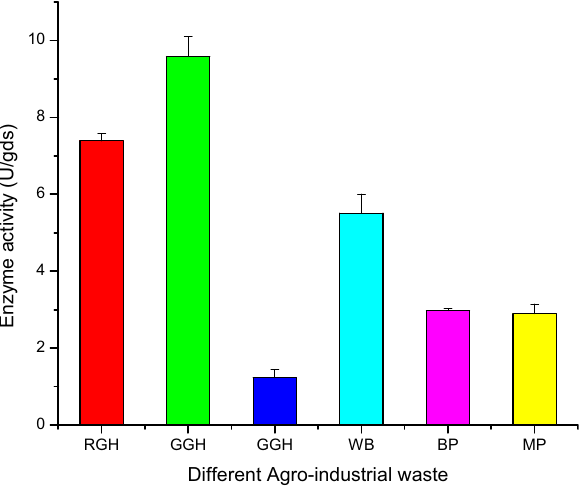
Figure 1. Selection of agro-based substrates for pullulanase production. RGH, red gram husk, GGH, green gram husk, BGH, black gram husk, WB, wheat bran, BP, banana peel, MP, mausambi peel; error bar indicates the average of triplicates ± standard deviation.